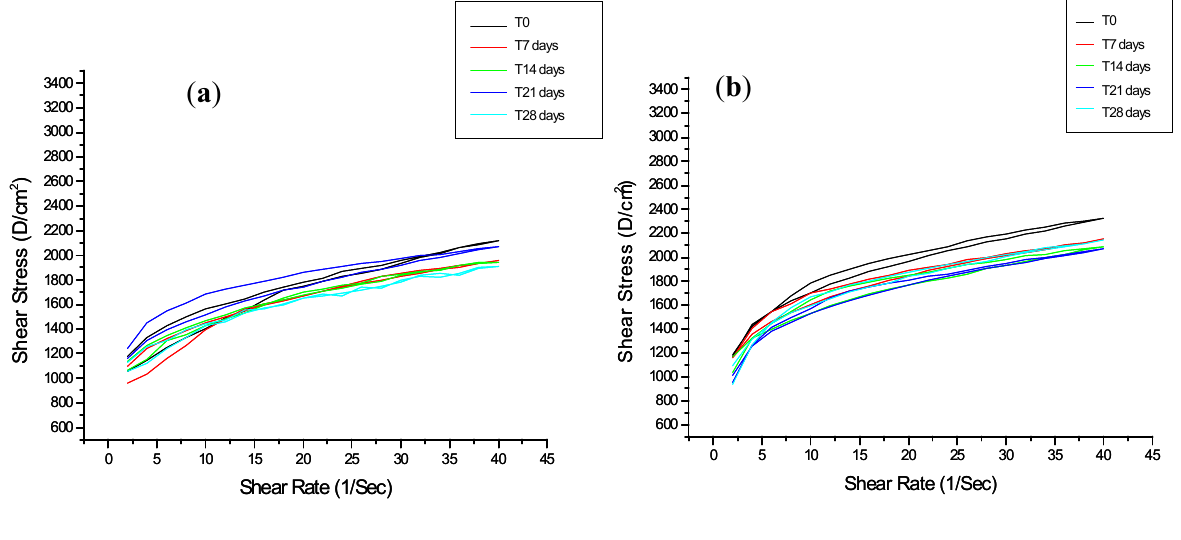
Figure 1. Rheograms of formulations supplemented ( b ) or not ( a ) with the combination of vitamins under study, when stored at 25 °C, during 0, 7, 14, 21 and 28 days after preparation. ( a ) formulation with vitamins in combination stored at 25 °C; ( b ) formulation without vitamins stored at 25